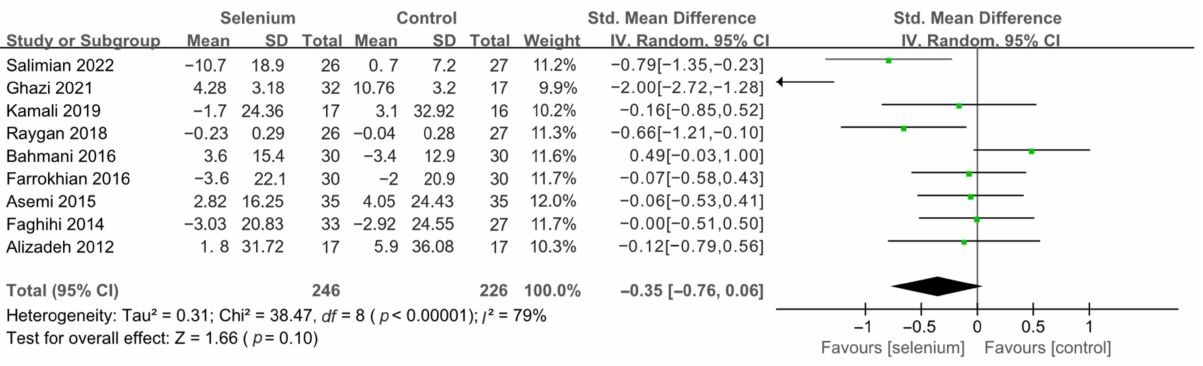
Figure 12. Forest plot of LDL-C